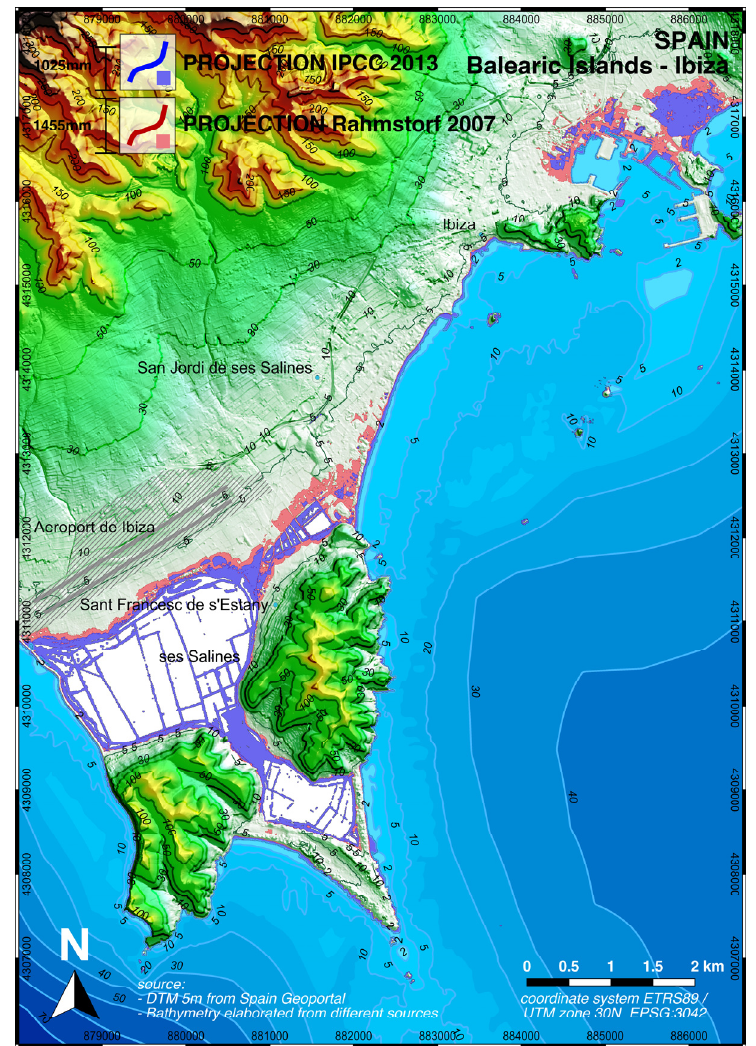
Figure 9. Map 16 Ibiza (Spain), see also Figure 1 for location). The potential submersion area, using Rahmstorf 2007 projections are 4.2 km 2 . Rahmstorf 2007 projections are 4.2 km 2